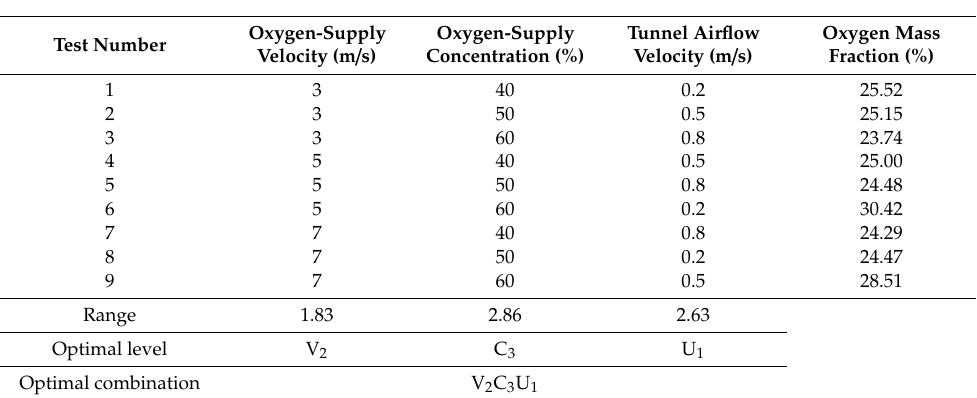
Table 3. Orthogonal experimental